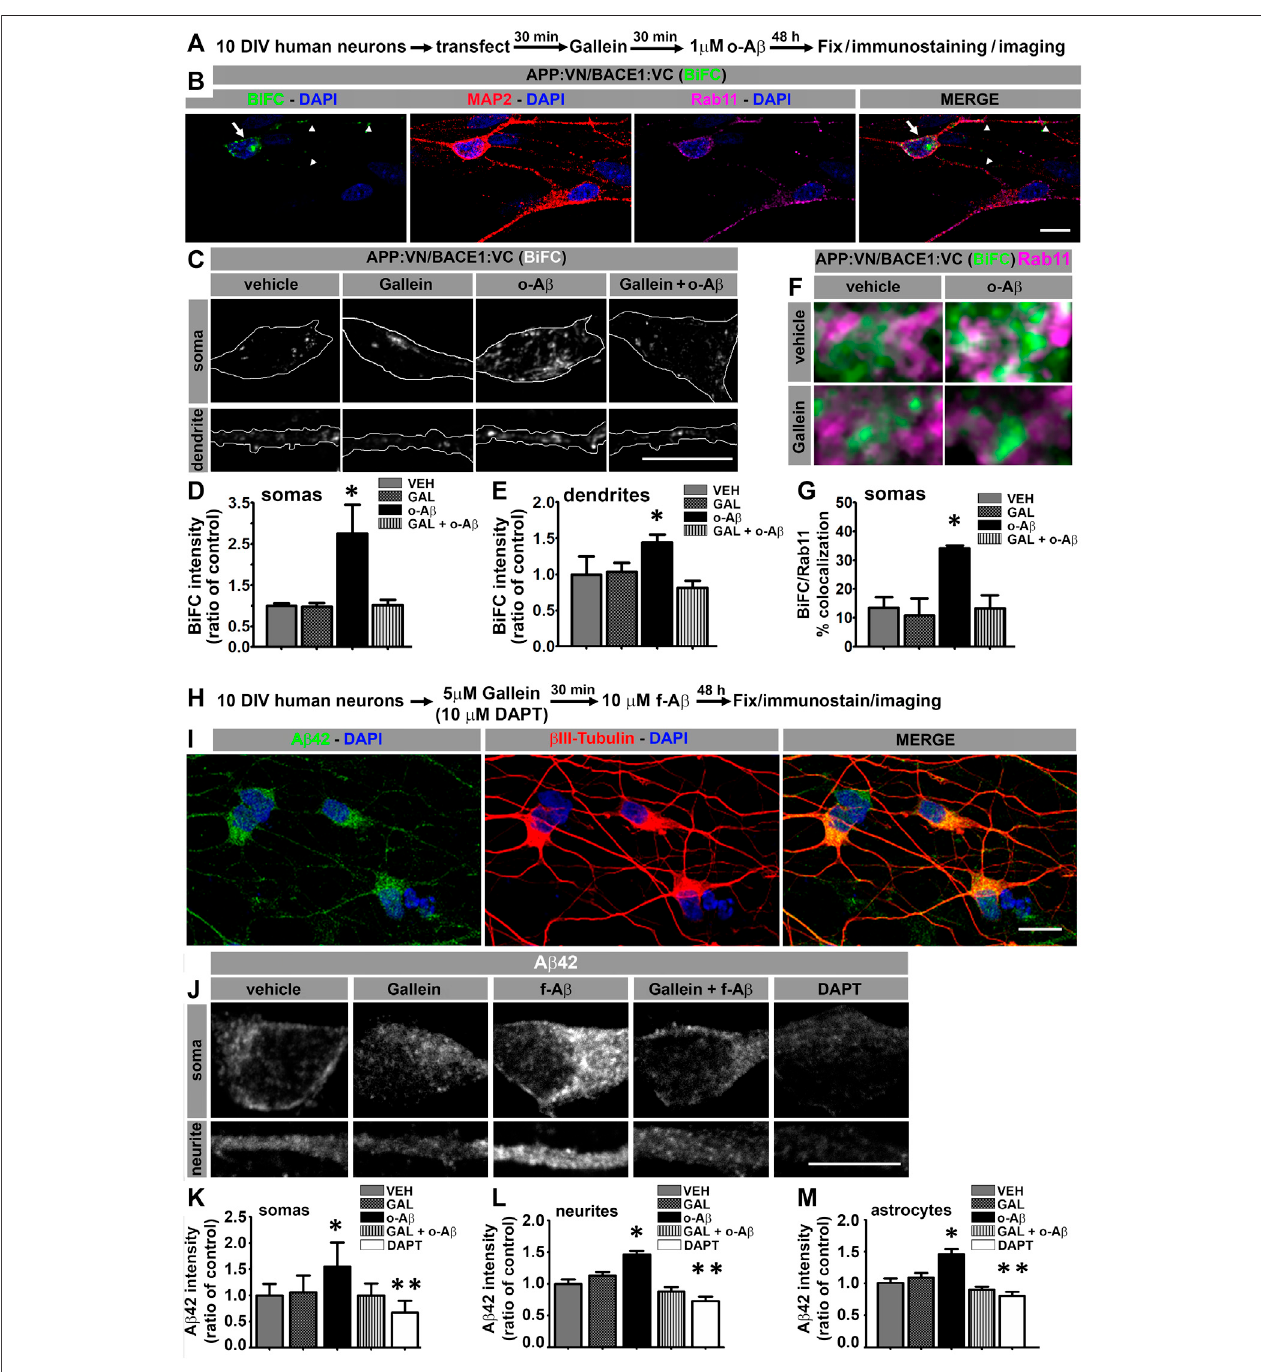
FIGURE 4| A β assemblies promote APP:VN/BACE1:VC interaction and intracellular A β 42accumulation in human iPSC-derived neurons through G βγ -dependent signaling. (A) .Experimental diagramforB-G. (B) .Confocal imageof12DIVhumanneurons immunolabeled withantibodies toMAP2and Rab11depictingBiFCofAPP: VN andBACE1:VC. BiFCincellbodyanddendritesisindicatedwitharrowsandarrowheads,respectively.NucleiwerestainedwithDAPI. (C) .Representativeimagesof magni fi ed (×3) areas of somas and dendrites of human neurons treated under the indicated conditions showing BiFC of APP:VN and BACE1:VC. (D) . Intensity of BiFC in somas expressed as ratio of control (n = 27; 6 – 9 cells for each condition) *: p < 0.001 vs. all other conditions by ANOVA followed Fisher LSD post-hoc test. (E) . IntensityofBiFCofAPP:VNandBACE1:VCindendritesexpressedasratioofcontrol(n=52;11 – 14cellforeach condition)*: p < 0.05vs.allotherconditionsbyANOVA followed Fisher LSD post-hoc test. (F) . Representative images of the magni fi ed area (×5) of somas of human neurons treated under the indicated conditions and depicting BiFC (green) and endogenous Rab11 (magenta). White pixels indicate colocalization. (G) . Manders coef fi cient of colocalization of BiFC and Rab11